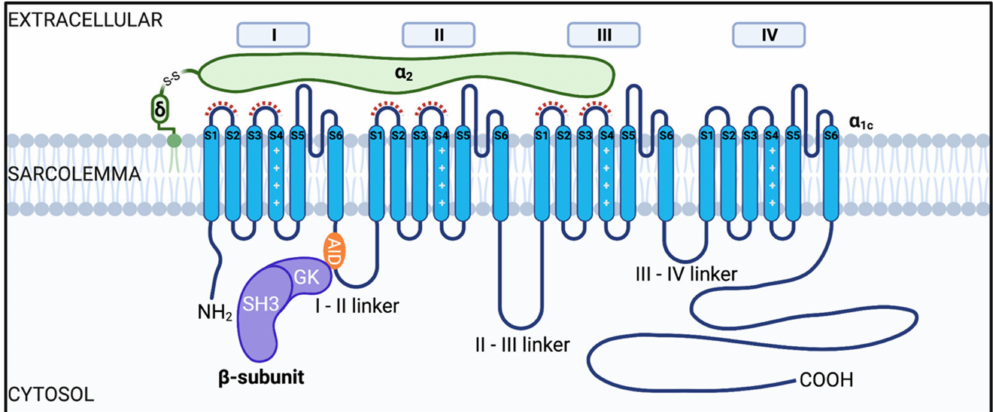
Figure 1. Illustration of the cardiac voltage gated L-type Ca V 1.2 channel complex. The channel consists of a pore-forming Ca V α 1C subunit and auxiliary subunits Ca V β and Ca V α 2 δ . The Ca V α 1c is composed of four homologous repeat domains (I-IV), each having six transmembrane spanning segments (S1–S6, shown in blue). S1–S4 comprise the voltage sensing domain (VSD) and S5–S6 form the pore domain (PD). Ca V β subunits (depicted in purple) are composed of a SH3, HOOK, and GK domain. Interaction of Ca V β with the Ca V α 1 c occurs between the GK domain on Ca V β subunits and the alpha interaction domain (AID) on the I-II linker (orange). Ca V α 2 δ subunits are proposed to interact with the extracellular loops of domains I-III as highlighted by the red dashed lines